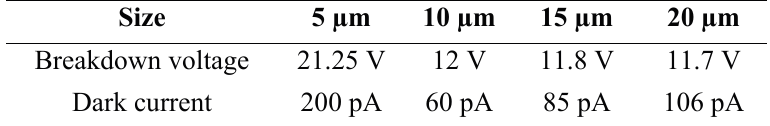
Table 1. Breakdown voltage and dark current for each photodiode size.